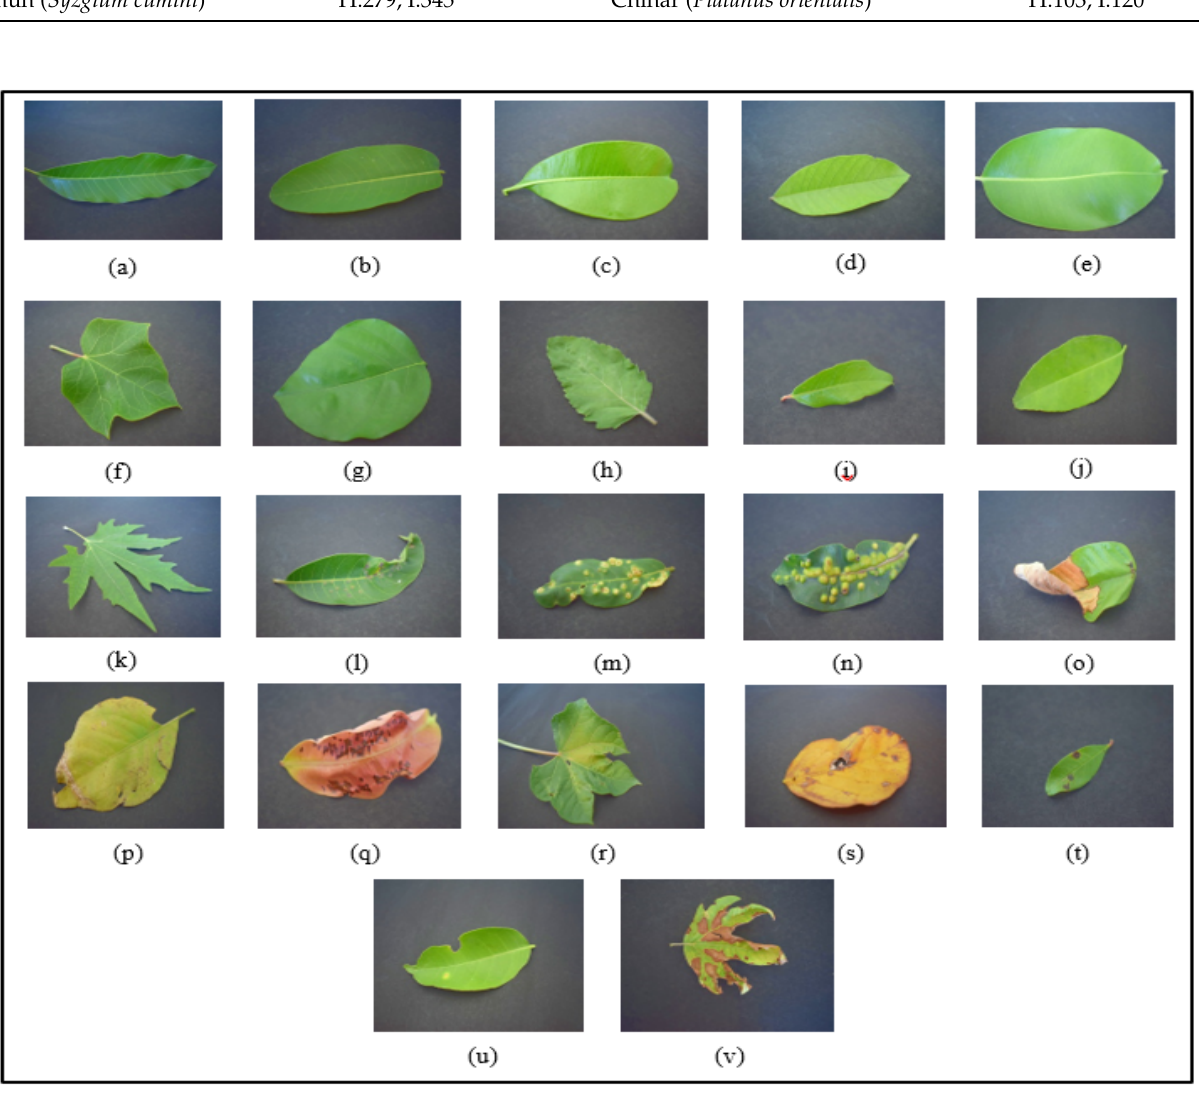
Figure 3. Image samples post pre-processing stage ( a ) Mangifera indica -H, ( b ) Terminalia arjuna -H, ( c ) Alstonia scholaris -H, ( d ) Psidium guajava -H, ( e ) Syzgium cumini -H, ( f ) Jatropha curcas L.-H, ( g ) Pongamia Pinnata L.-D, ( h ) Ocimum basilicum -H, ( i ) Punica granatum L.-H, ( j ) Citrus limon-H, ( k ) Platanus orientalis-H, ( l ) Mangifera indica-D, ( m ) Terminalia arjuna-D,